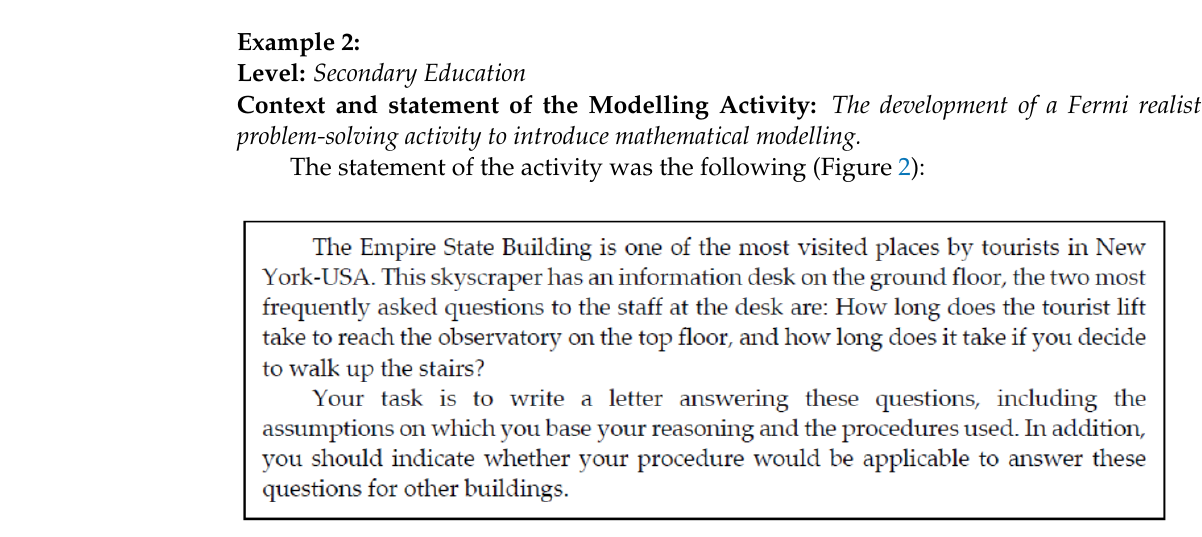
Figure 2. Adapted from Ärlebäck [49].